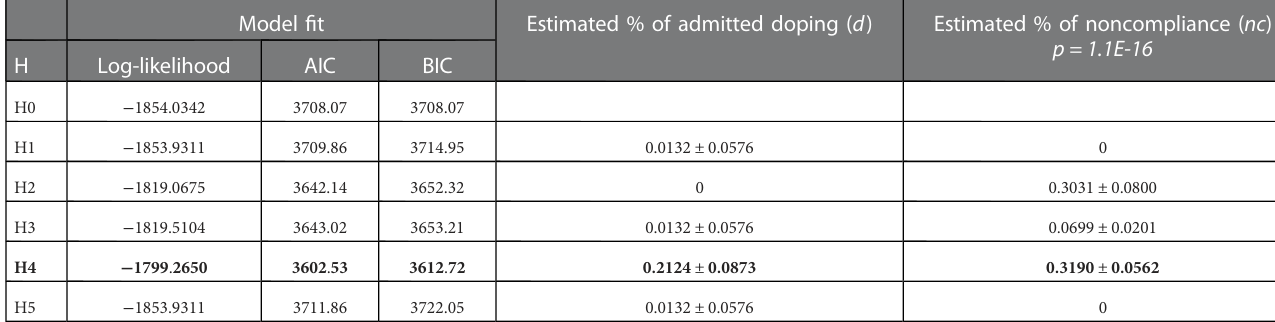
TABLE 4 Estimated use of prohibited performance enhancing substances and/or methods at WCA (12-month